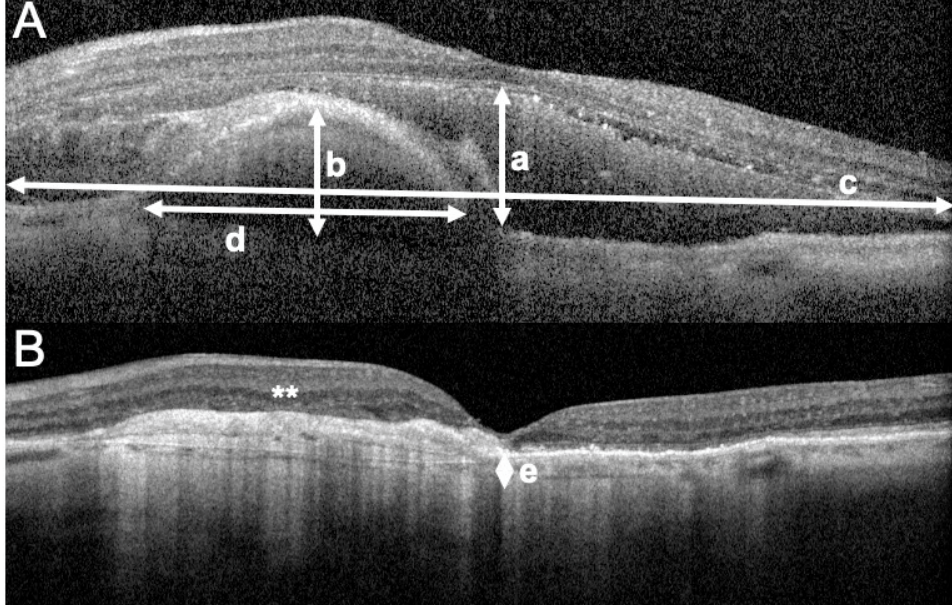
Figure 2. Optical coherence tomography (OCT) B scans passing by the foveal center, representing the left eye of an 81- year-old female presenting with macular hematoma consecutive to type-1 choroidal neovascularization due to age related macular degeneration. ( A ) OCT picture at the time macular hematoma occurrence. The height (a) and width (c) of the subretinal portion of the hemorrhage are represented with white arrows. When larger than the scale of the OCT B-scan, the maximum visible width is measured (c). The height and width of the sub-retinal pigment epithelium (RPE) portion of the hematoma are represented in (b) and (d). The size of the sub RPE portion of the hematoma is measured on the same B-scan as the subretinal portion of the hemorrhage. ( B ) OCT picture taken 6 months after surgery, showing complete displacement of the hematoma, the development of fibrotic lesions (white asterisks,**) at the level of the preoperative subRPE hemorrhage and atrophy of the photoreceptor layer. The post-operative B scan is obtained as a reference for the measurement of the subfoveal choroidal thickness (e). The pre-operative best corrected visual acuity was 0.05 decimals improving to 0.14 decimals at 6 months of